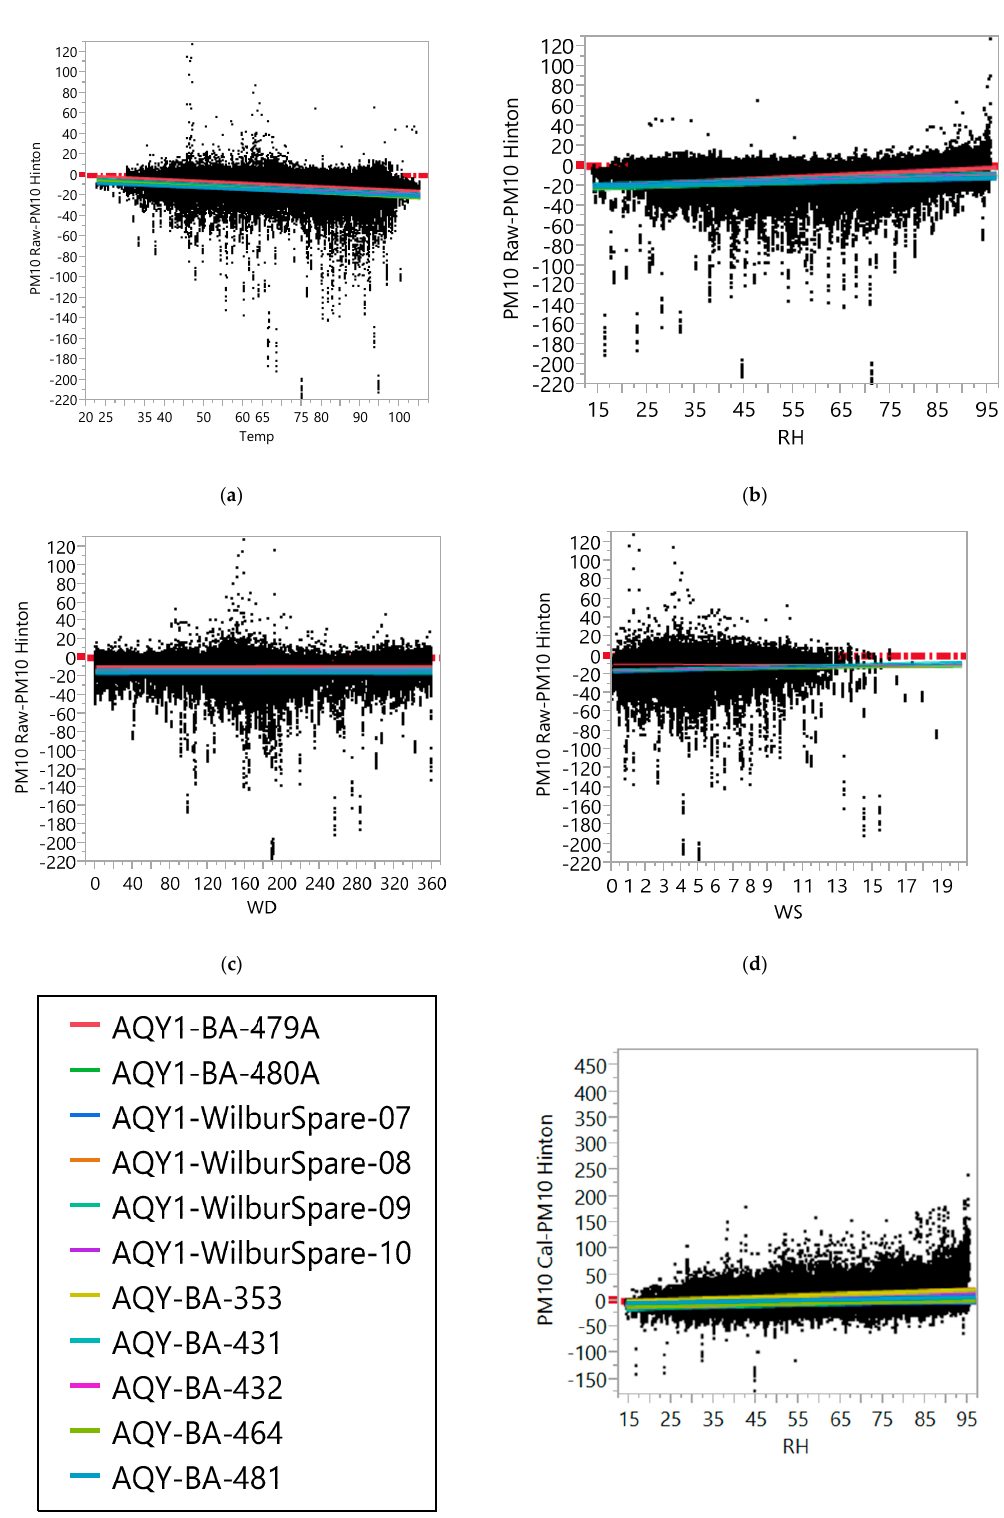
Figure 5. Regression Plot between PM 10 Raw - PM 10 Hinton Data versus ( a ) Temperature, ( b ) RH, ( c ) Wind Direction, ( d ) Wind Speed, ( e ) between PM 10 Calibrated - PM 10 Hinton Data versus the RH, as measured at the Hinton Reference Site